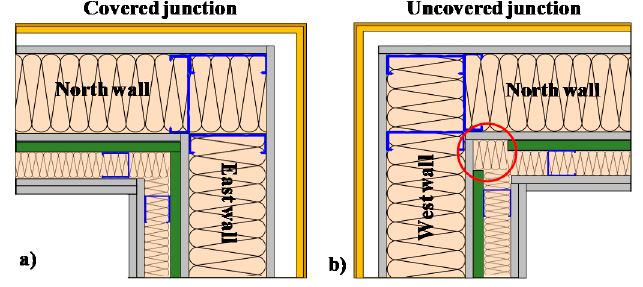
Figure 3. The junction between the two walls: ( a ) proper insulation and ( b ) dimensional inaccuracy. The roof (Table 1) load-bearing structure was constructed with I-shaped steel studs (I-studs), with dimensions 200 mm × 100 mm and 1.5 mm thickness equally spaced at 500 mm. The Theoretical U-value: 0.12 W/(m 2 K) (including thermal bridges due to studs) intermediate gaps between the I-studs were filled with 200 mm thick mineral wool. A load panel was anchored on the external side of the metal structure, while a gypsum board layer was installed at the internal side. An EPS insulation layer, 80 mm thick, protected by finishing mortar, was applied on the external surface of the roof. The total thickness of the roof is 327 mm. The floor (Table 1) was constructed with 1.5 mm thick, I-shaped steel studs (I-studs), with dimensions 200 mm × 100 mm, equally spaced at 500 mm. The intermediate gaps between the I-studs were filled with 200 mm thick mineral wool. A gypsum board layer was anchored on the ground side of the structure and a 160 mm thick EPS layer was installed at the bottom of the floor. A load panel, a sound insulation layer, and a floor panel were placed at the internal side of the structure. The total thickness of the floor is 455 mm. 2.2. Material Properties The thermal properties of the materials are presented in Table 2. The thermal conductivity of the individual materials used for the construction of the walls was either measured in the laboratory using the guarded hot plate (GHP) technique or obtained from the manufacturer’s datasheets. The density and the specific heat of the materials were all obtained from the manufacturer’s datasheets or relevant standards. Particularly, the effective thermal conductivity of the VIPs, λ eff , taking into account the thermal bridges at joints (edge effect) was estimated with the method described by Ghazi Wakili et al. [32]. According to this method the linear thermal transmittance, Ψ VIP , at the joint of two adjacent VIPs is calculated by means of the measurement of the center-of-panel thermal conductivity ( λ cop ) and the thermal conductivity at the joint of two panels. The VIP’s effective thermal conductivity ( λ eff ) including the edge effect was calculated according to the following equation: